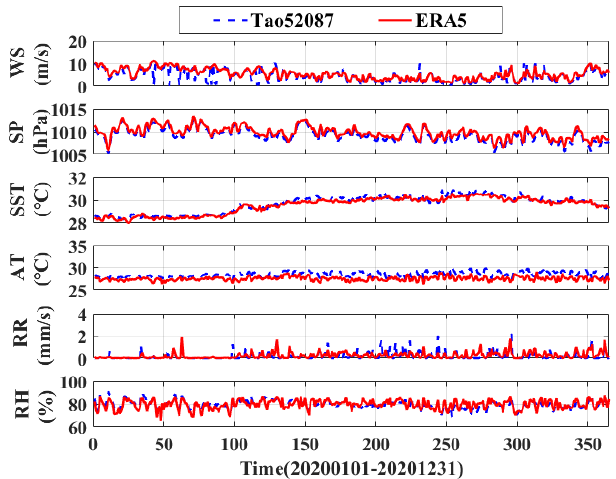
Figure 3. Comparison of TAO52087 buoy data and ERA5 reanalysis data in 2020.